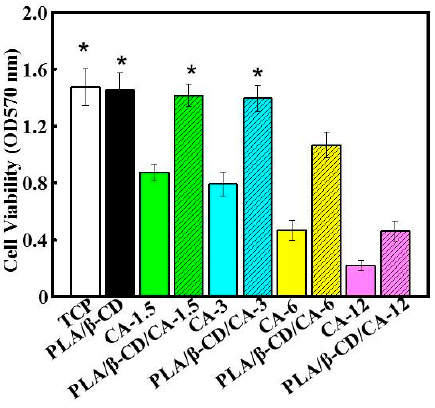
Figure 6. Cytotoxicity of different fi bers on CCC-HSF-1 using MTT assay ( n = 6, * means p < 0.05).